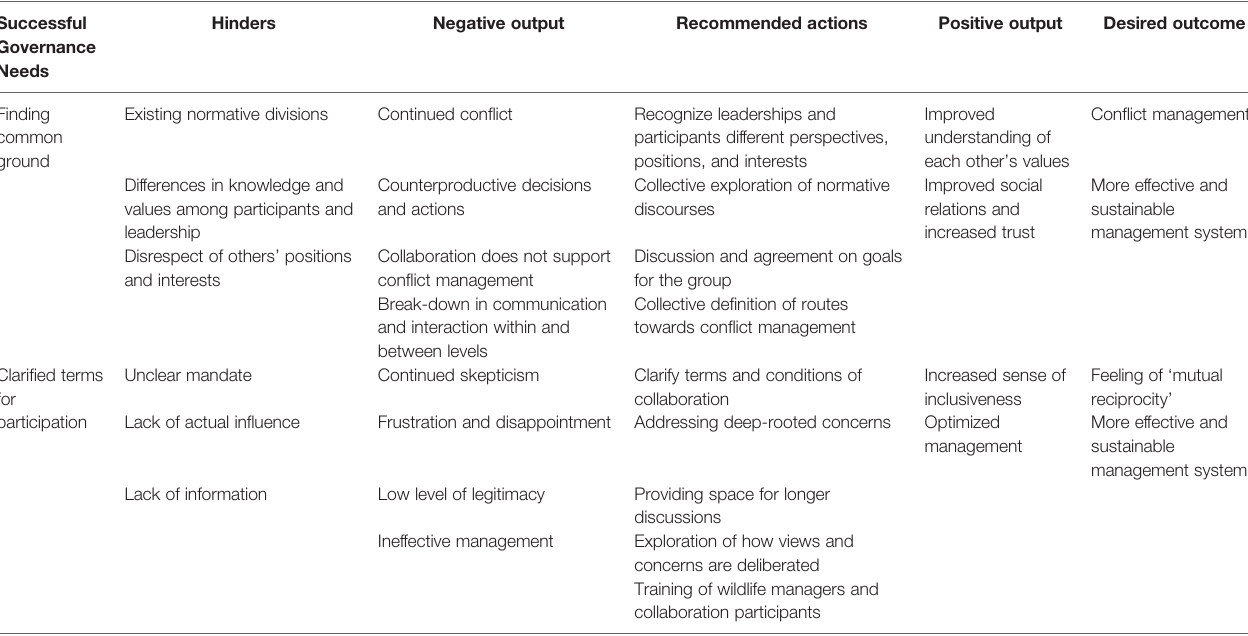
TABLE 1 | Addressing hinders and potential for con fl ict management through collaboration. Successful